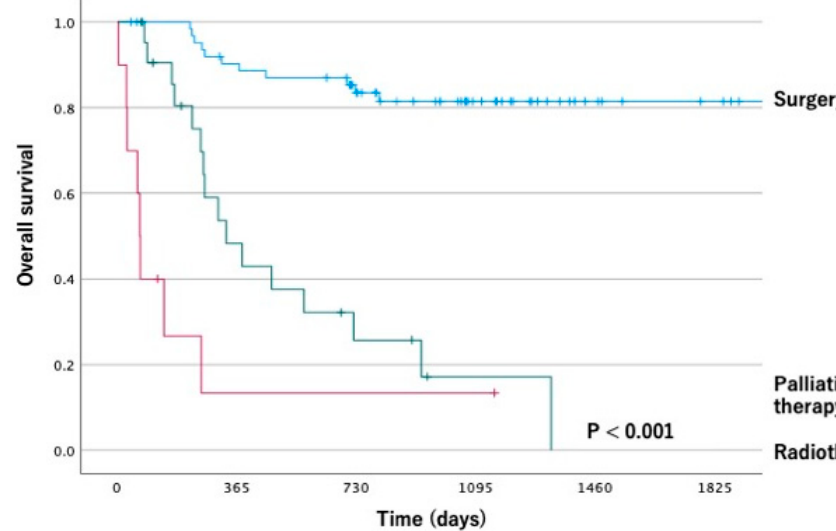
Figure 1. Kaplan–Meier survival curve according to the age group.